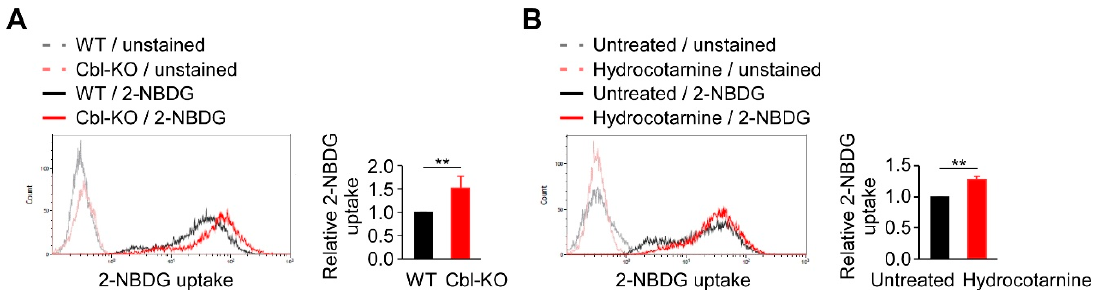
Figure 4. Cellular glucose uptake was found to be regulated by Cbl. ( A ) A representative flow cytometry plot of three experiments on glucose uptake in WT and Cbl-KO THP-1-derived macrophages. ( B ) A representative flow cytometry plot of three experiments on glucose uptake in hydrocotarnine-treated and untreated THP-1-derived macrophages. ** p < 0.01. All results are presented as the mean ± SD of three independent experiments and were analyzed using Student’s t -test.